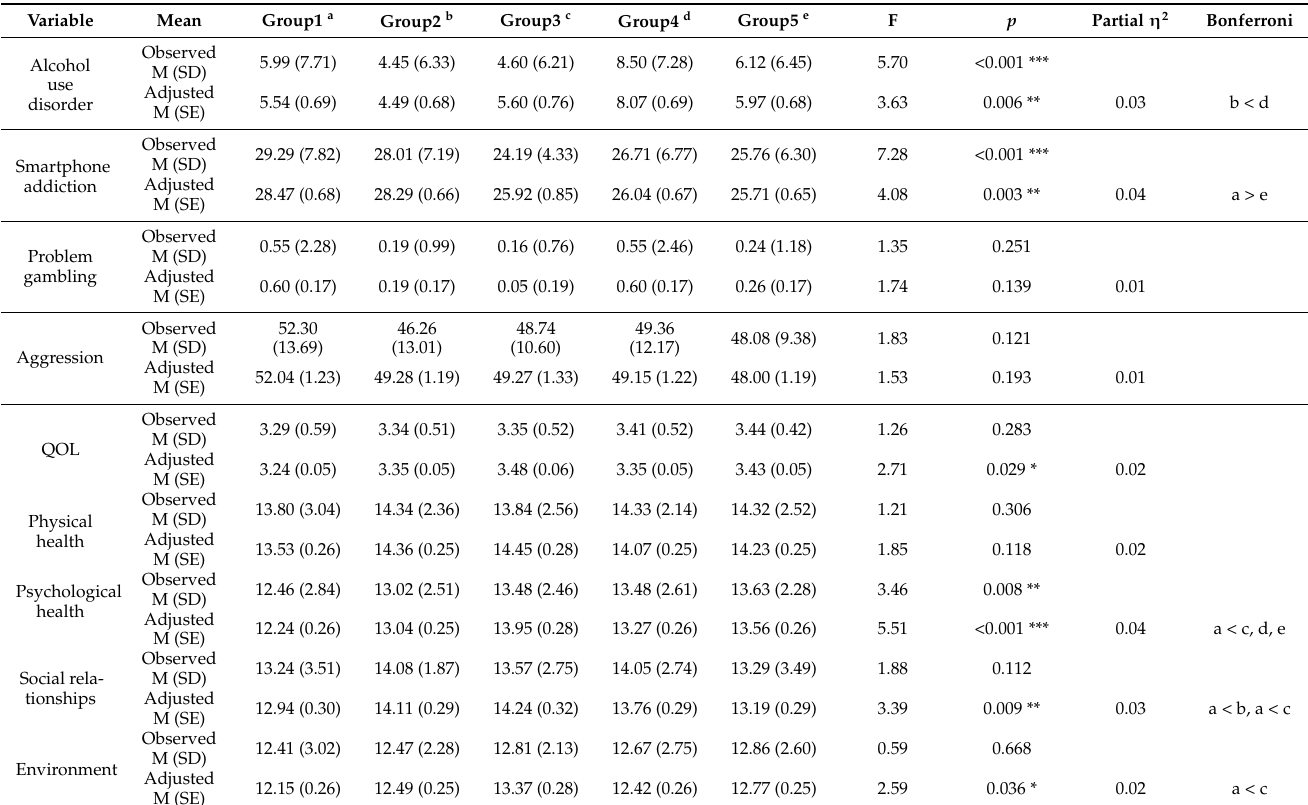
Table 3. Comparison of variables between